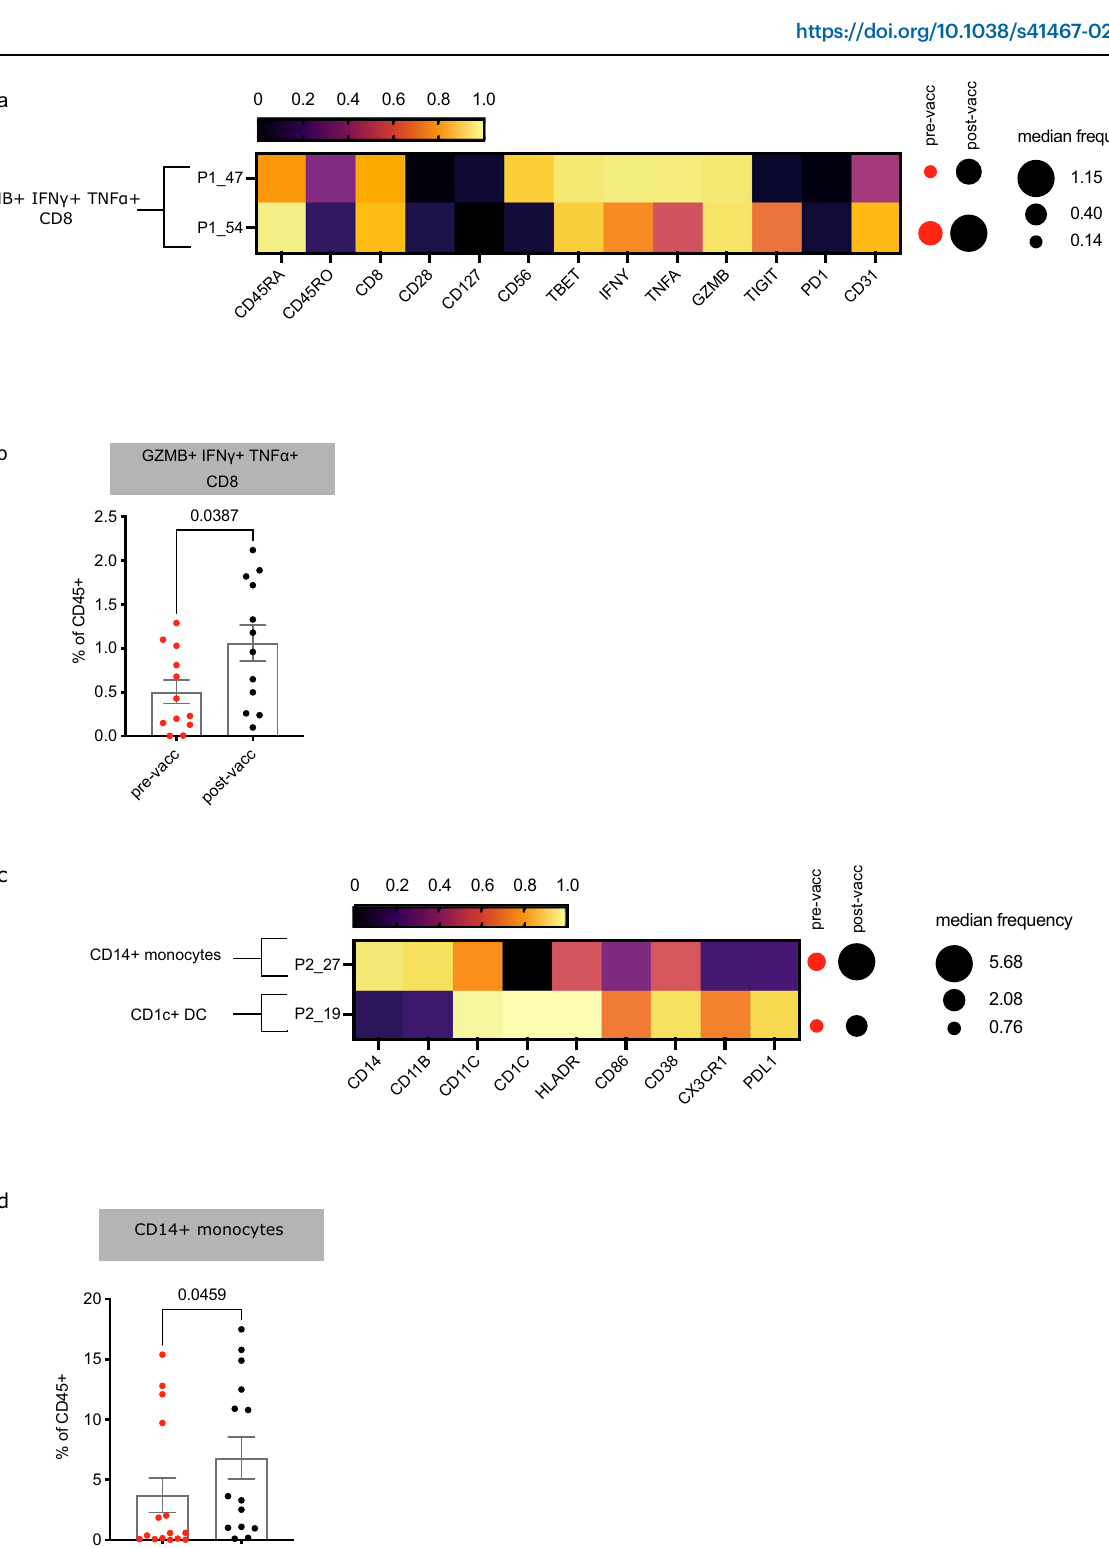
gated clusters in ( c ) Pre-vaccination: n =15, post-vaccination: n =14. Heatmap represents the scaled arcsin median expression of each marker. P -values were computedbyMann – WhitneyUtest(two-tailed).ErrorbarsindicateSEofmean.For each staining panel, some sampleswere excluded from supervisedanalyses due to insuf fi cient cell numbers. Source data are provided as a Source Data fi